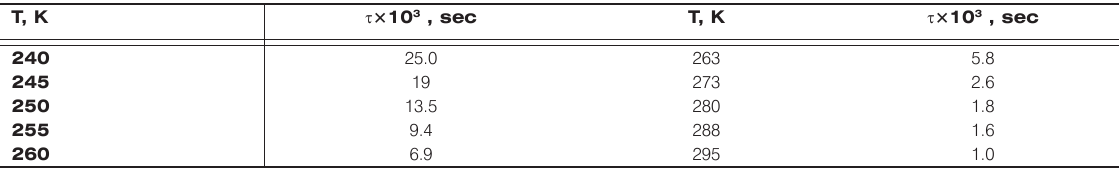
with 2.5 moles of water added. 7